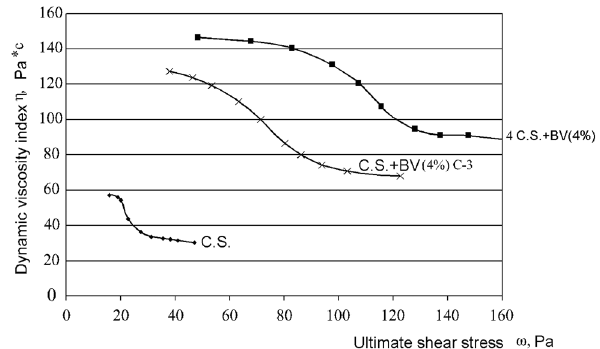
Figure 11: Dependence of the structural viscosity of the fi ber - rein - forced cement paste of cement stone; cement stone, fi ber ( 4% by weight of cement ) , and superplasticizer C3; cement stone and fi ber.